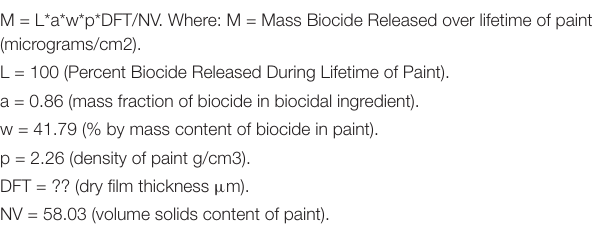
TABLE 1 | Formula to calculate mass biocide release rate from paint (ISO 10890,